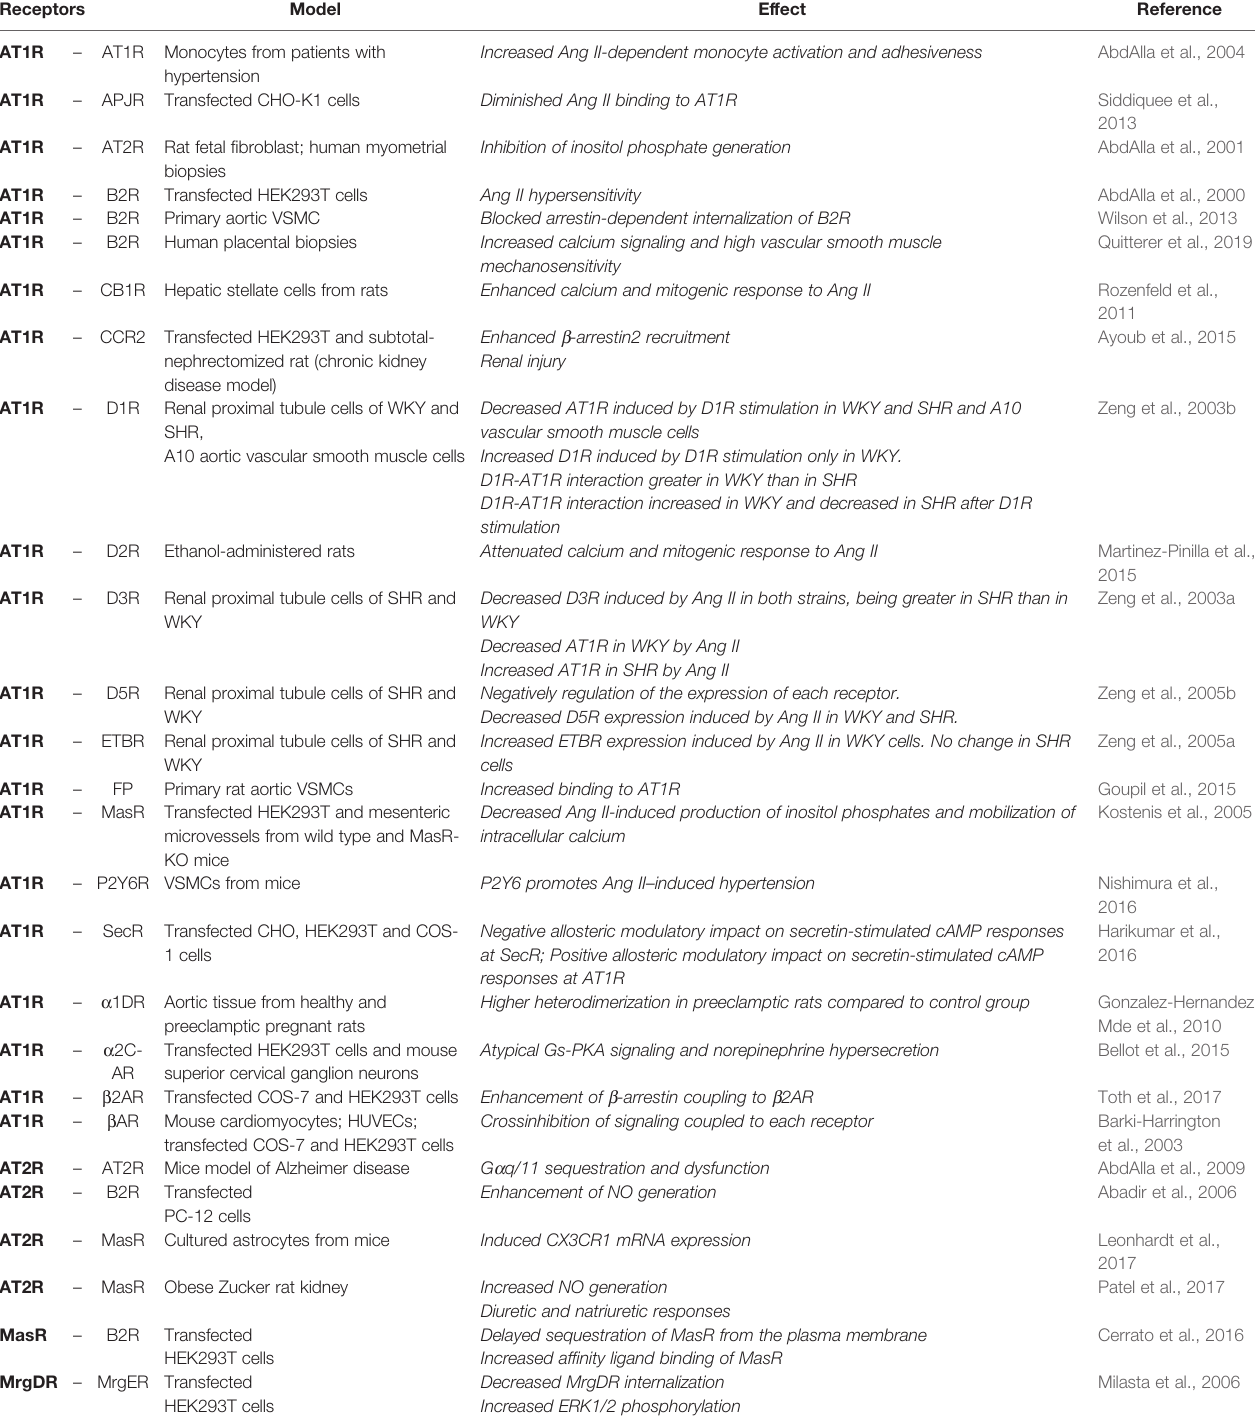
TABLE 1 | Angiotensin Receptors heteromerization and its functional